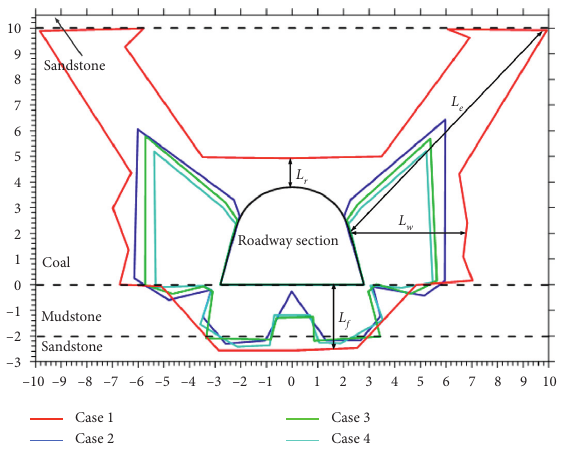
Figure 9: Comparison of failure zones for different